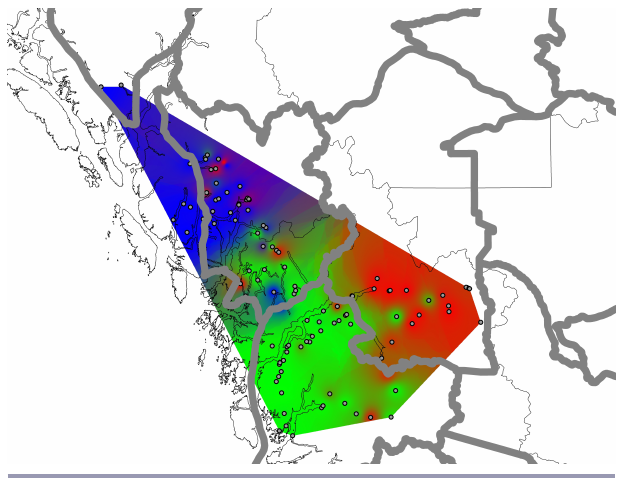
Fig. 3. Map showing grizzly bear population genetic structure and grizzly bear population unit (GBPU) management boundaries. Inverse distance weighting-interpolated STRUCTURE population Q -value map shows grizzly bear populations (blue = G1, green = G2, red = G3). Dark grey lines = GBPU boundaries; light grey points = individual mean detection